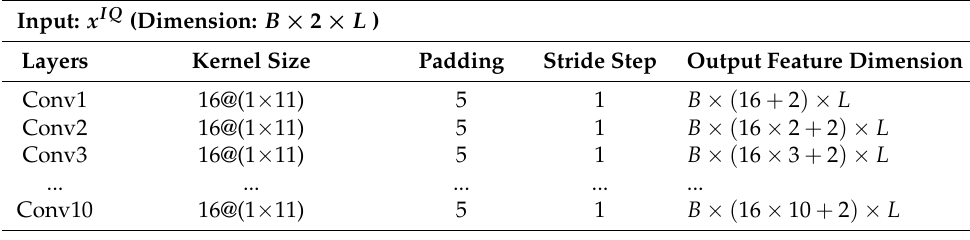
Table 1. The hyperparameters of the DenseNet part of the